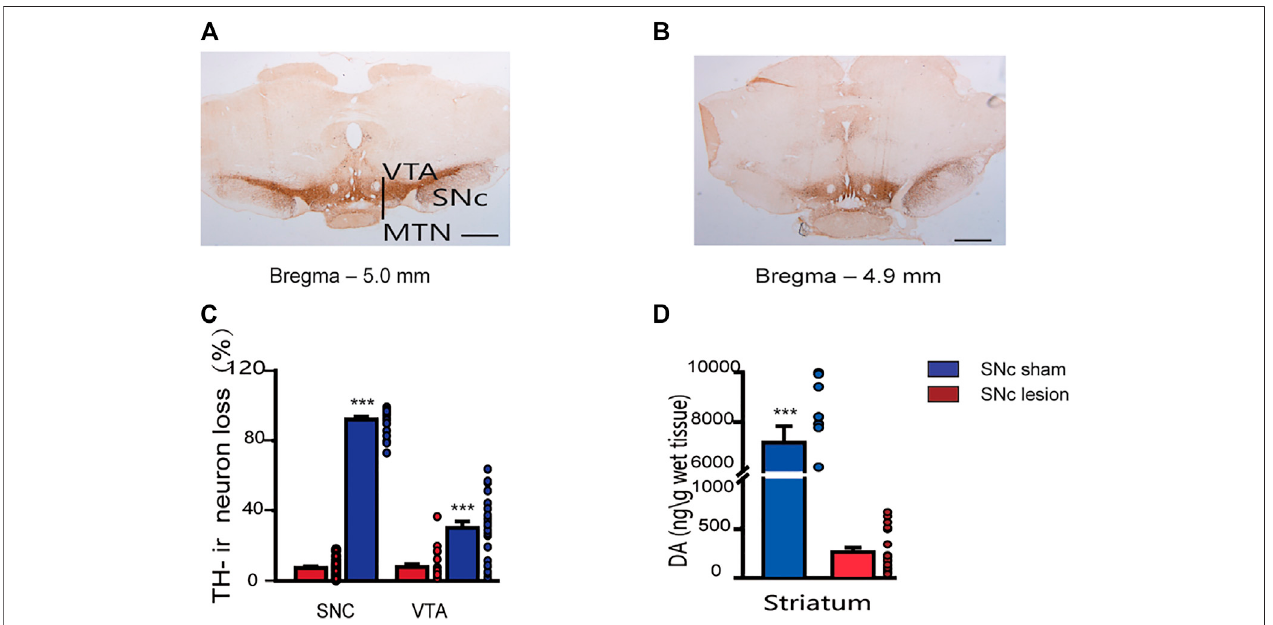
FIGURE2| StainingofdopaminergicneuronsintheSNcandVTA,andDAtissuecontentinthestriatuminsham-operatedandSNc-lesionrats.Photomicrographs showTHimmunostainingoftheSNcandVTAinsham-operated (A) andSNc-lesion (B) rats.Aunilateralinjectionof6-OHDAintotheSNcinaratledtoanearlycomplete lossofTH-irneuronsintheSNcandapartiallossintheVTA,comparedtosham-operatedrats[ (C) ;sham-operated: n =24rats/group;SNc-lesion: n =23rats/group].A unilateralinjectionof6-OHDAalsodecreasedtheDAlevelintheipsilateralstriatumcomparedtosham-operatedrats[ (D) ; n =28rats/group].*** p < 0.001 vs .sham- operated rats; unpaired Student ’ s t -test. Data are represented as means ± SEM. MTN, medial terminal nucleus of the accessory optic tract. Scale bars: A, B = 500 μ m.